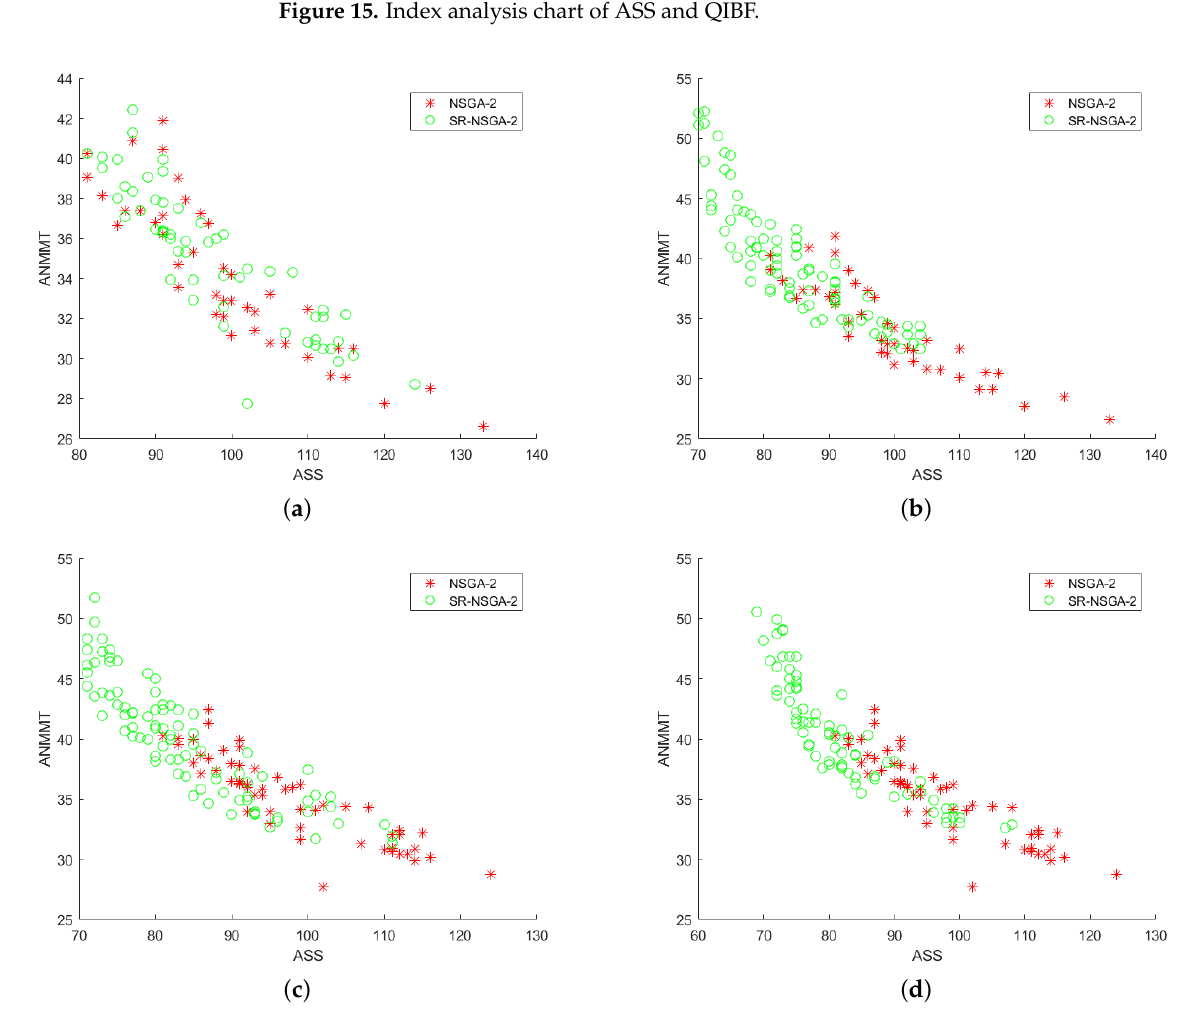
Figure 15. Index analysis chart of ASS and QIBF.